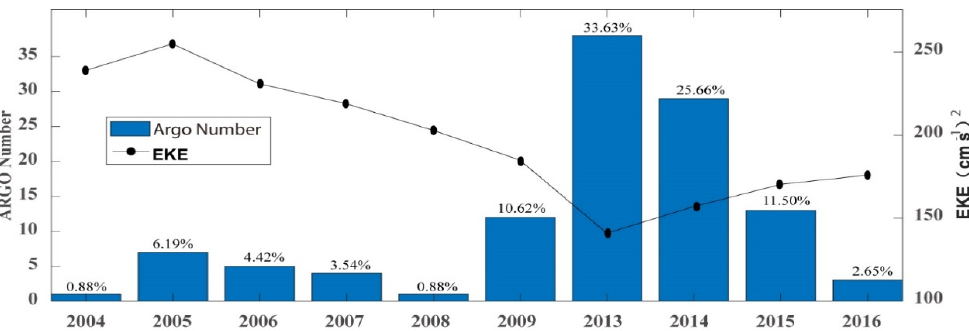
Figure 14. Composite eddy years with SSTA > 0 obtained from the ARGO and EKE data distributions.